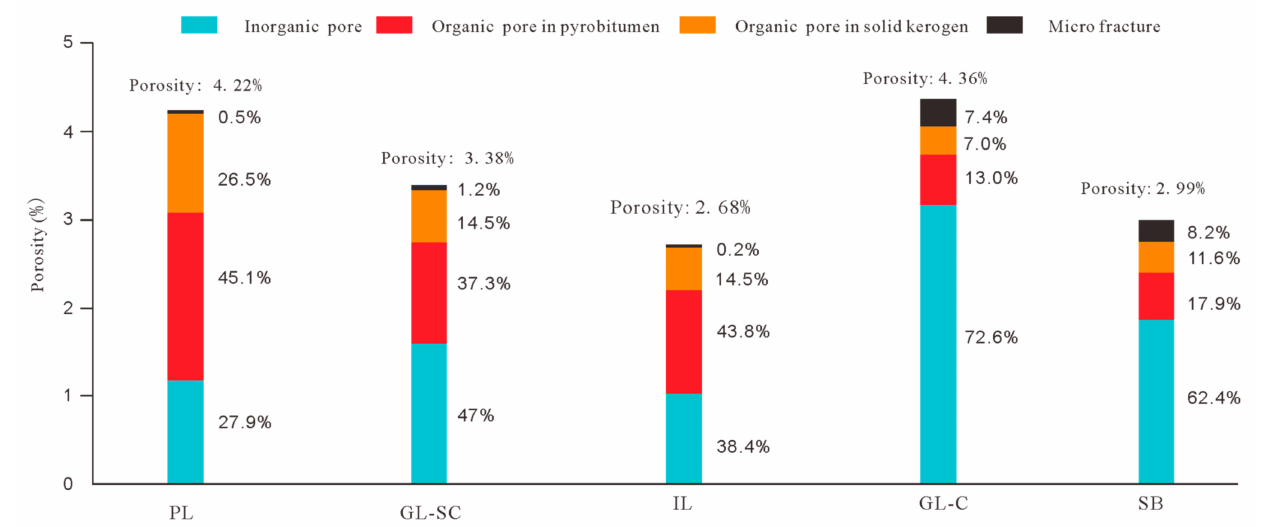
Figure 13. Porosity distribution in various lamination shale. For the PL, GL-SC, and IL, organic pores account for more than 50% of the total porosity, whereas for the GL-C and SB, inorganic pores account for more than 50% of the total